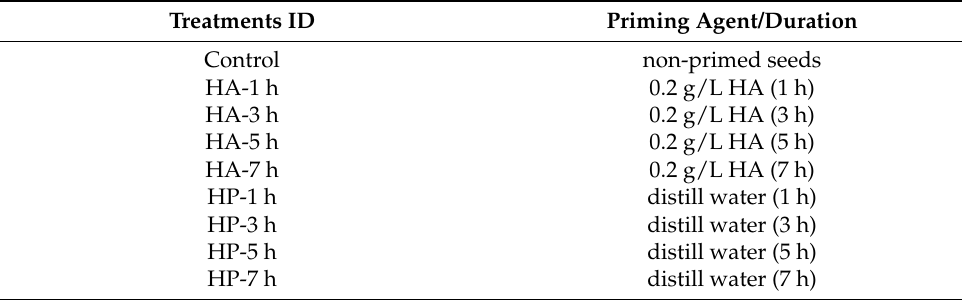
Table 1. Priming agent and the soaking duration for each